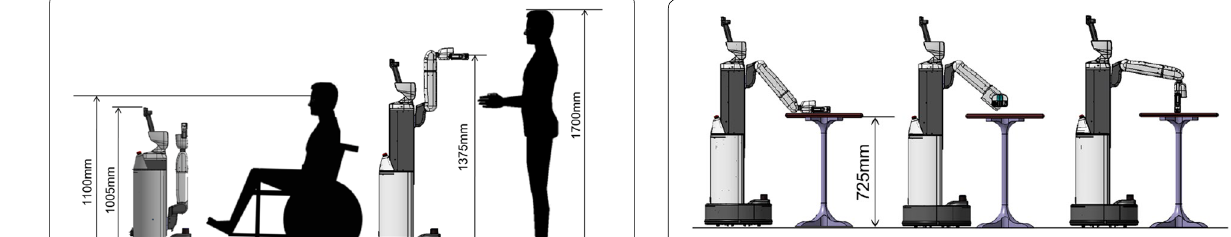
Fig. 12 Picking from floor in three directions